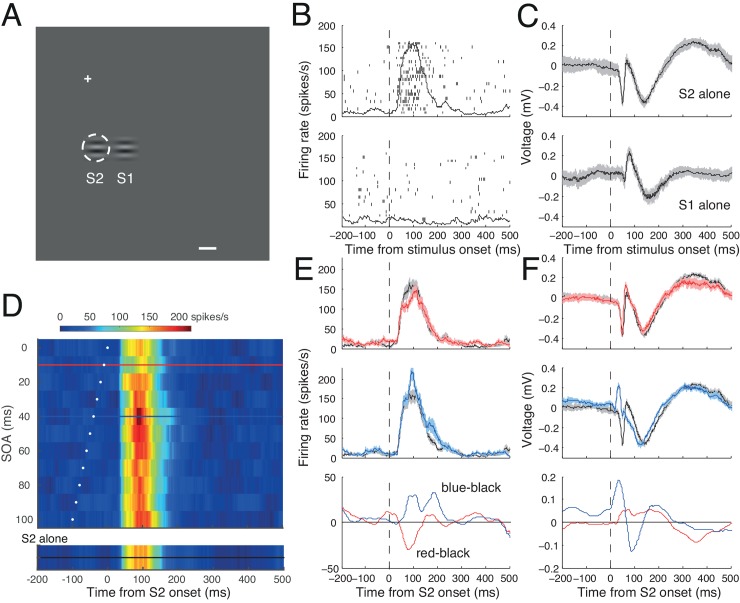
Spike and LFP activity of another representative cell.Same conventions as Fig 3. A. The RF was centered 0.6° right and 4.0° down. B, C. Raster and spike density plots (B) and mean LFP traces (C) in response to S2 alone (upper) and S1 alone (lower) aligned at their onset times. Shadings indicate ±2 SE. D. SOA time plot. Representative spike densities for SOA of 10 and 40 ms are indicated by red and blue horizontal lines, respectively. E, F. Upper and middle panels: Spike (E) and LFP activity (F) in response to S1-S2 sequences with SOAs of 10 (red) and 40 ms (blue); black traces indicate references taken from the S2-alone condition. Bottom panels: The magnitude of modulation (S1-S2 sequence minus S2-alone condition) in spike (E) and LFP (F) are plotted for SOAs of 10 ms (red) 40 ms (blue). Note that for the SOA of 10 ms, the magnitude of modulation in spike activity was negative (suppressed) and the modulation of LFP was relatively weak, whereas for the SOA of 40 ms, the magnitude of modulation in spike activity was positive (facilitated) and the modulation of LFP was relatively strong.